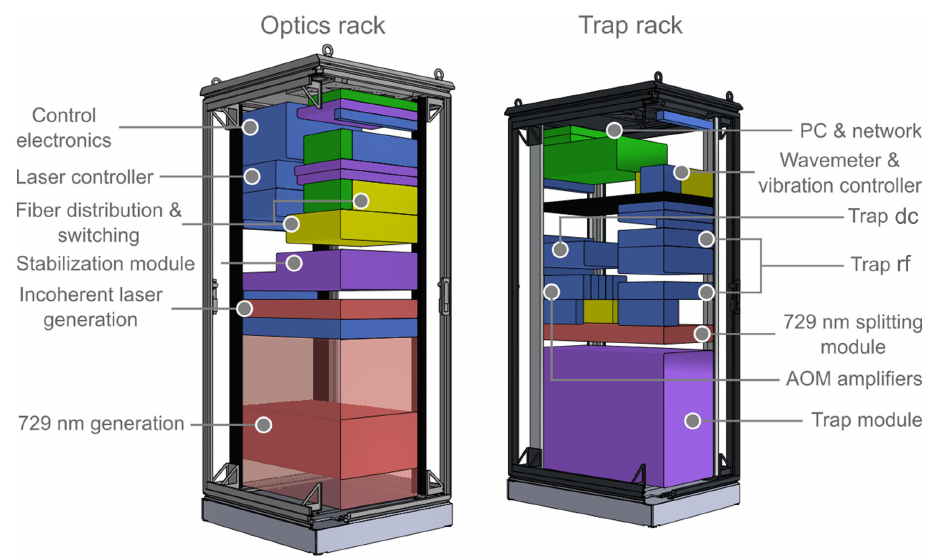
FIG. 2. Simplified scale model of the quantum computing demonstrator housed in two 19-inch racks with major components labeled. Modules in red correspond to optical systems, green for communication and readout, blue electronics and amplifiers, yellow fiber routing and switching, and purple for miscellaneous core modules. The “optics rack” contains primarily light generation, switching and routing modules with associated electronics. It additionally houses the coherent radio frequency (rf) and digital signal generation module. The “trap rack” houses the main trap module with associated drive electronics, as well as the communications and remote control hub. Interconnects between modules and racks via electrical and optical patch cords. Semitransparent red is the planned 729 nm light generation